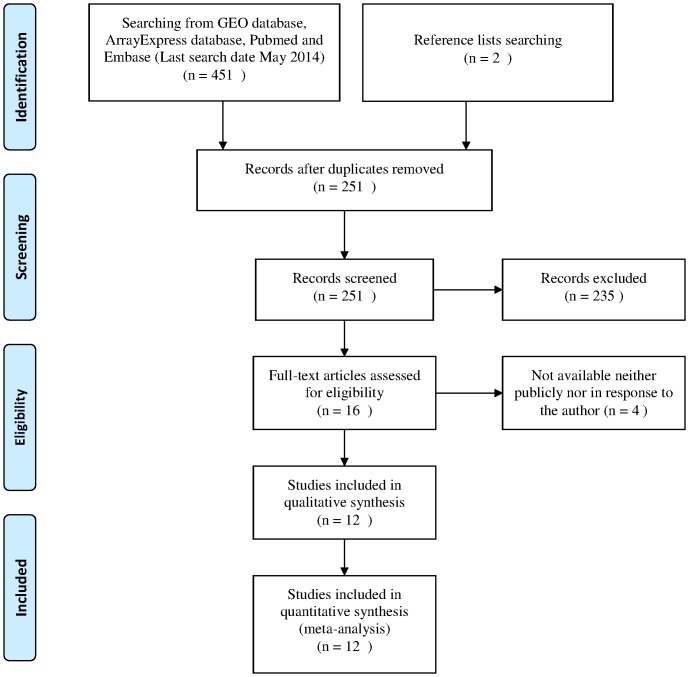
Searching strategy.